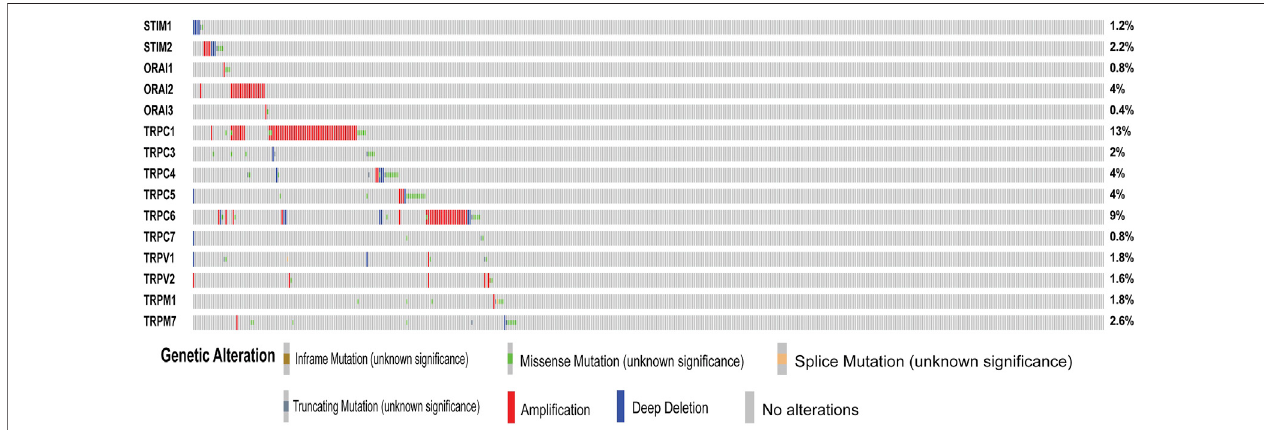
FIGURE 2 | Mutations in SOCs. The mutations in genes associated with SOCs were analysed across the TCGA fi re hose ( n = 504) datasets using Cbioportal. Oncoprint plot was downloaded from the Cbioportal website. The color for different genetic alterations are mentioned at the bottom. Each row in the plot represents a gene and column represents a tumor sample. The percentage of reported mutation rate across the tumor samples ( n = 504) are represented on the right-hand